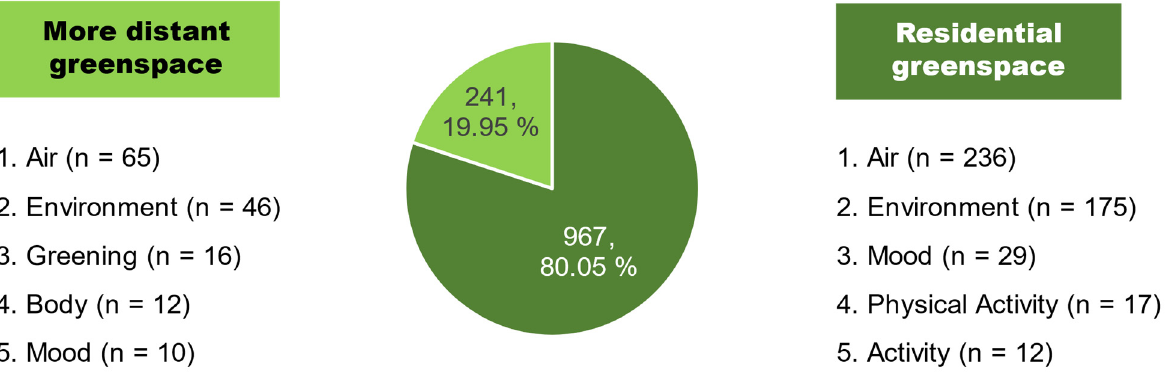
Figure 2. Proportion of respondents reporting green exercise in different urban green spaces and top five keywords for reasons to engage in green exercise ( n = 1208). Note: n : times of the keywords appeared in respondents’ answers.